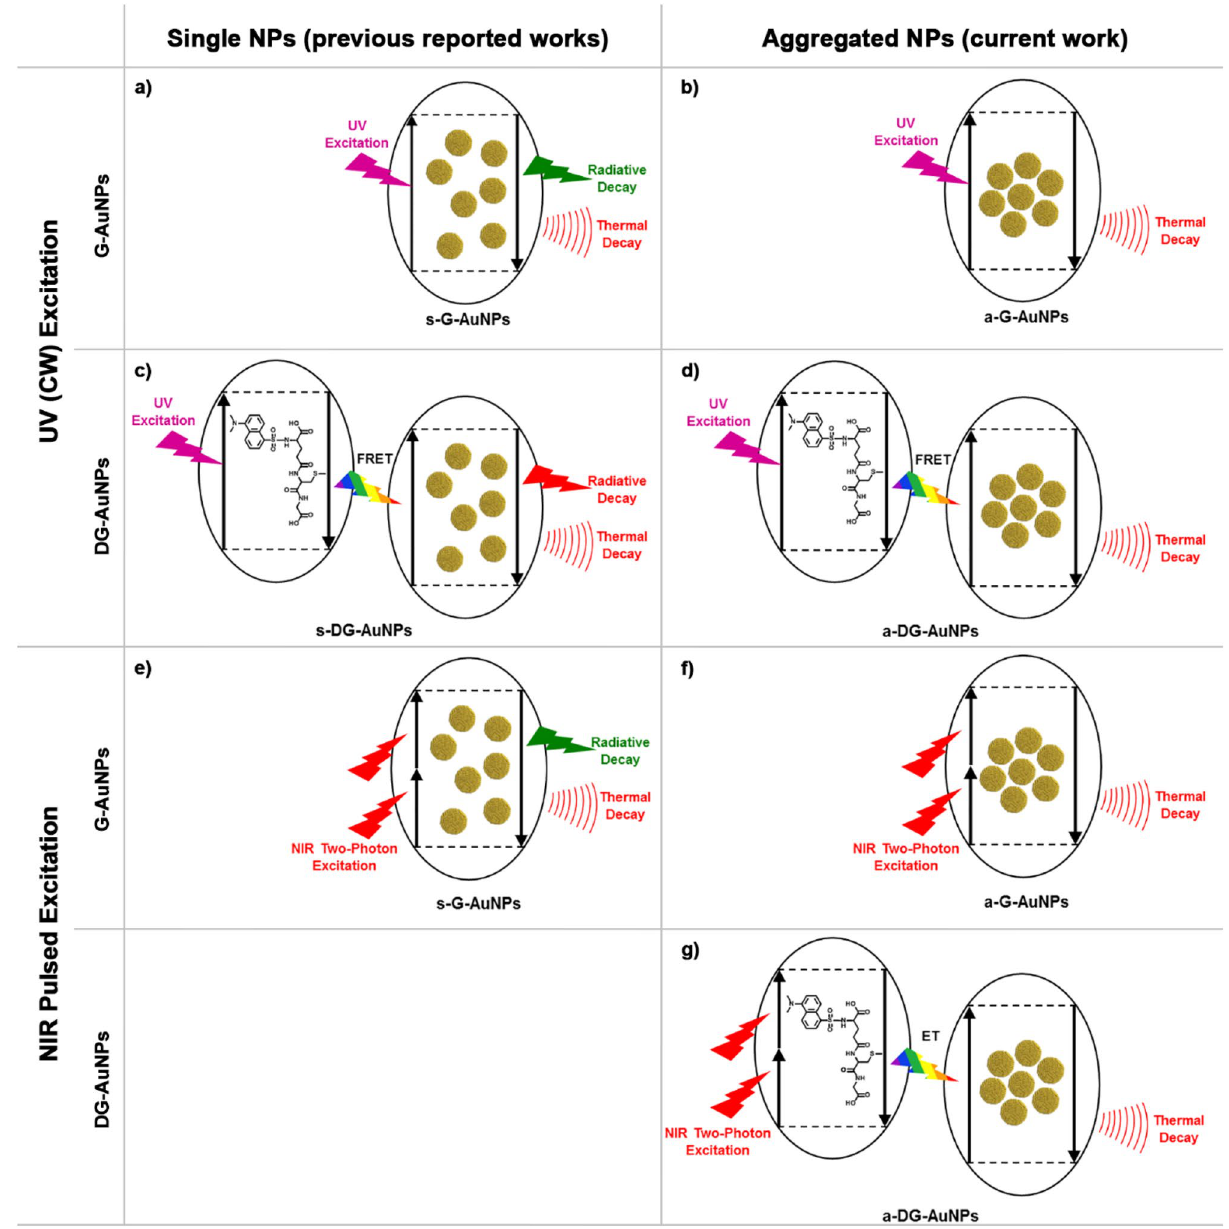
Figure 8. Photophysics of s-G-AuNPs, s-DG-AuNPs, a-G-AuNPs and a-DG-AuNPs under UV ( a – d ) and NIR two-photon excitation ( e – g